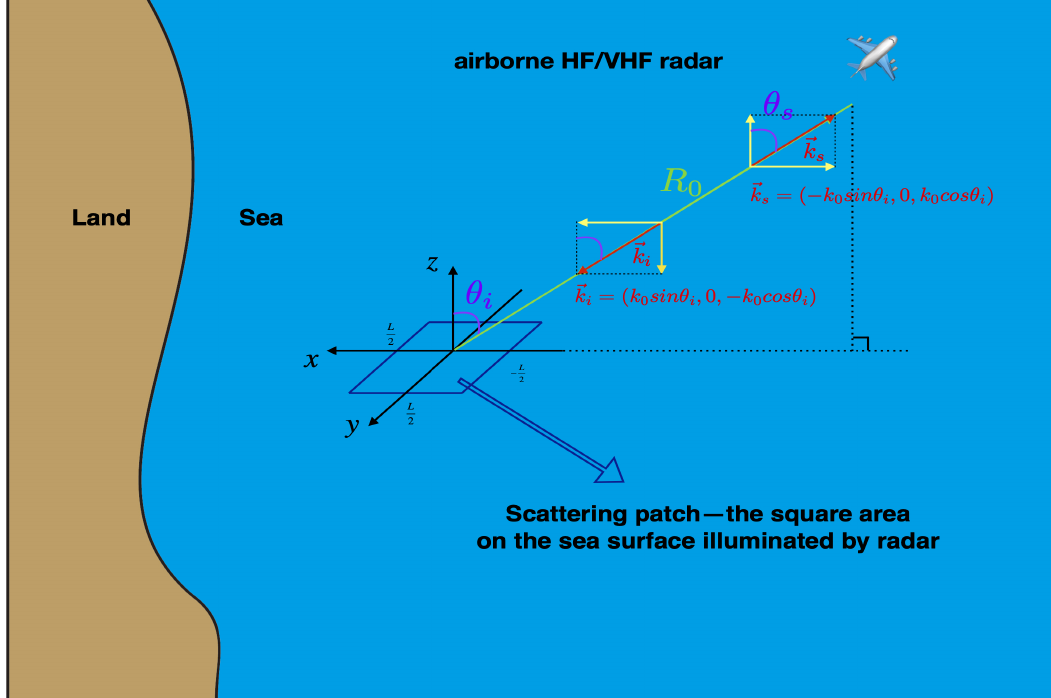
Figure 1. The geometry of the scattering patch. The square scattering patch is represented by the parallelogram whose sides are navy blue straight lines. The radar is located in the far zone of the scattering patch ( R 0 (cid:29) L ). Backscattering is considered, i.e., θ i = θ s . Here the x-z plane is perpendicular to the sea surface and contains the center of the scattering patch and the point of the radar position. (cid:126) k i and (cid:126) k s represent the wave vectors of the incident and scattered fields,